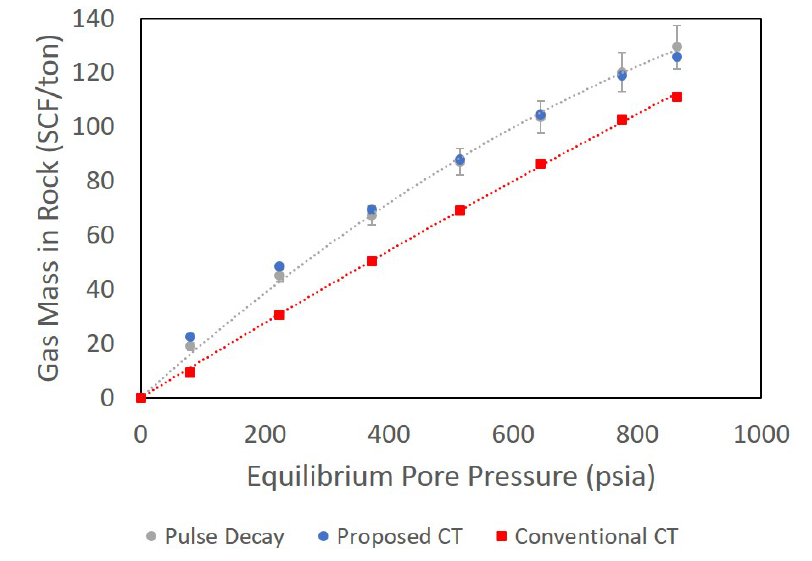
Figure 5. Comparison of proposed and conventional CT formulations for Kr storage capacity in Eagle Ford sample. Note the excellent agreement between the mass balance method (pulse decay) and the imaging approach that takes into account Kr density more accurately. The proposed CT routine and conventional CT method yield storativity values within 5% and 22%, respectively, of the mass balance derived results The CT curves are corrected to account for an additional 0.4 cm 3 of pore volume captured by the pulse decay material balance but not visible to the CT